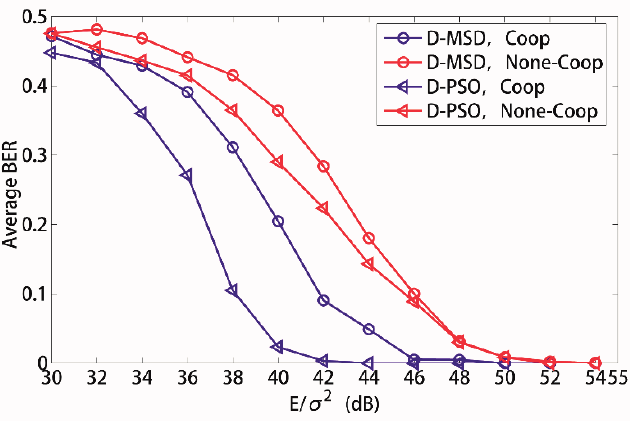
Figure 6. Influence of different transmission manner to the average BER. K = 8, N c =